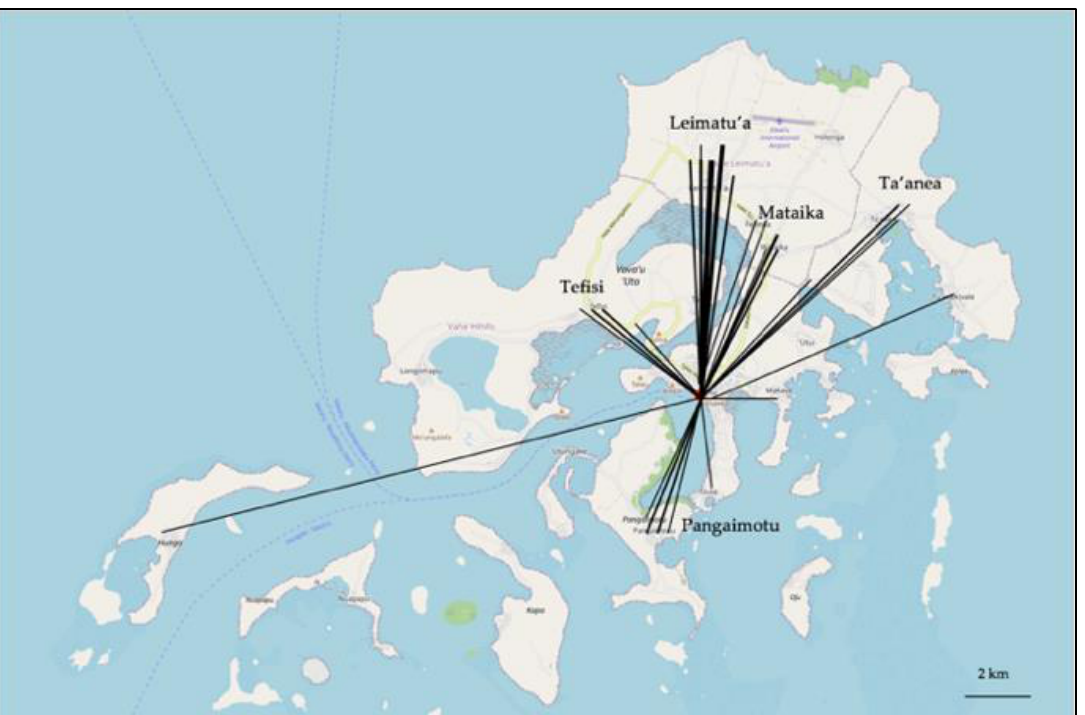
Figure 5. The location of farms supplying fruits and vegetables into the Utukalongalu municipal market, Neiafu, Utu Vava’u Island. Map source: Open street map 2019 and KoBoToolBox ™ with survey result overlays. Table 1. The horticultural production centres supplying Tonga’s fruit fresh and vegetable markets, associated transport logistics, and market vendor throughput.